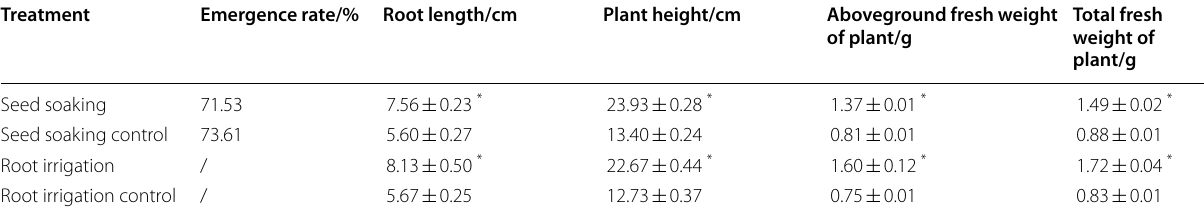
Data are mean SD; * indicates that there is a significant difference between the treatment and the control ( P < 0.05 ) ± Table 4 Controlling effects of different treatments of EBS03 against cotton Verticillium wilt in the field